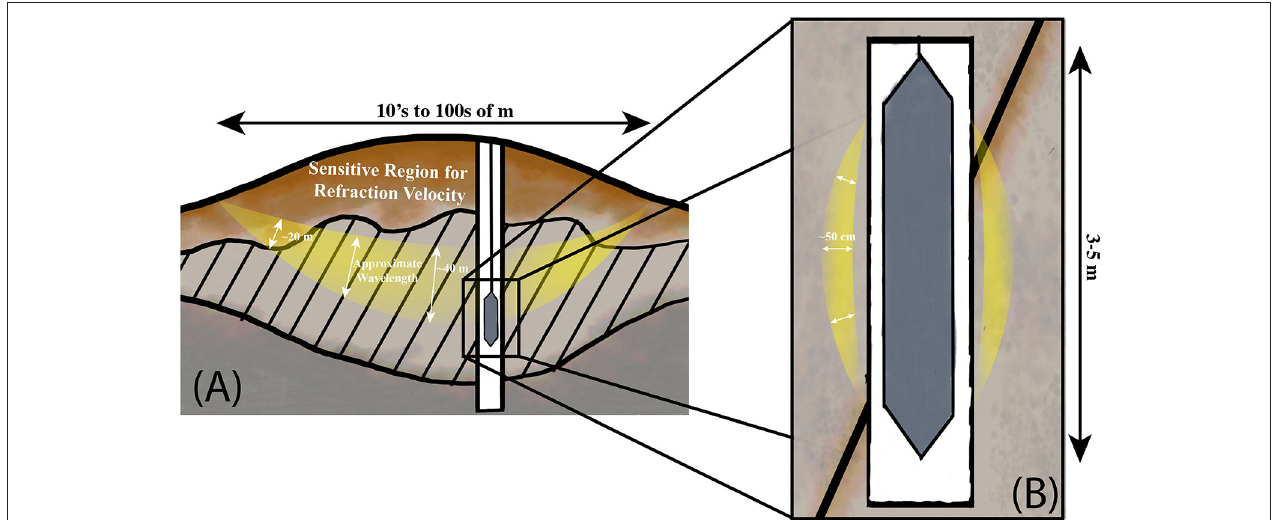
FIGURE 8 | A conceptual model illustrating the contrast in scales between a large-wavelength seismic wave (A) and a small-wavelength sonic tool (B) . Diagonal lines represent parallel fractures in the fractured bedrock layer. A seismic wave traveling from the source (star) to receiver (triangle) may have a wavelength of ∼ 50m in the fractured bedrock layer However the wavelength changes as a function of velocity ( Supplementary Figure S6 ). As a result, the wave “feels” a pervasively fractured medium and propagates at a correspondingly low velocity (say, 2,000 m/s). The sonic tool, in contrast, may have a wavelength of ∼ 0.5m, such that it senses fully intact, high-velocity bedrock in between fractures, and lower velocities as it crosses individual fractures. As a result, the refraction velocity will be substantially lower than sonic velocities in a fractured